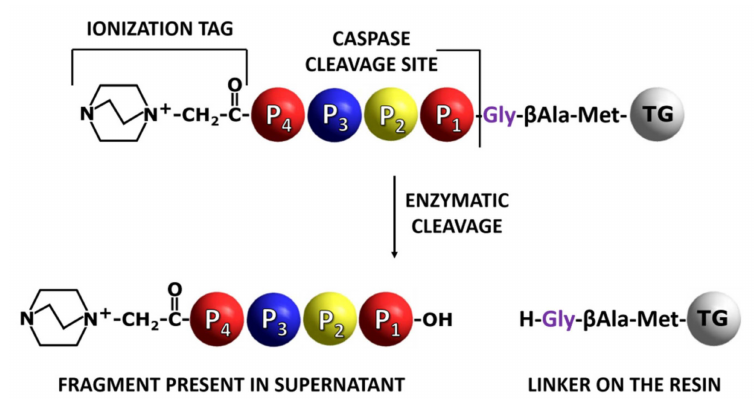
Figure 8. Schematic representation of the on-bead peptide proteolysis analysis using a resin-bound peptide modified by the ionization tag. TG: TentaGel resin.